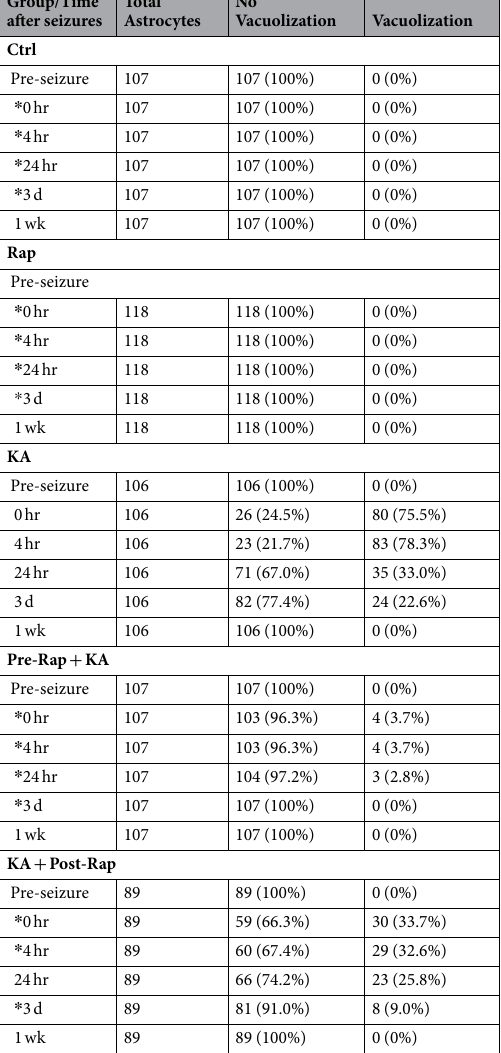
Table 1. Effect of rapamycin treatment on kainate seizure induced astrocyte vacuolization. * p < 0.05 vs. KA by